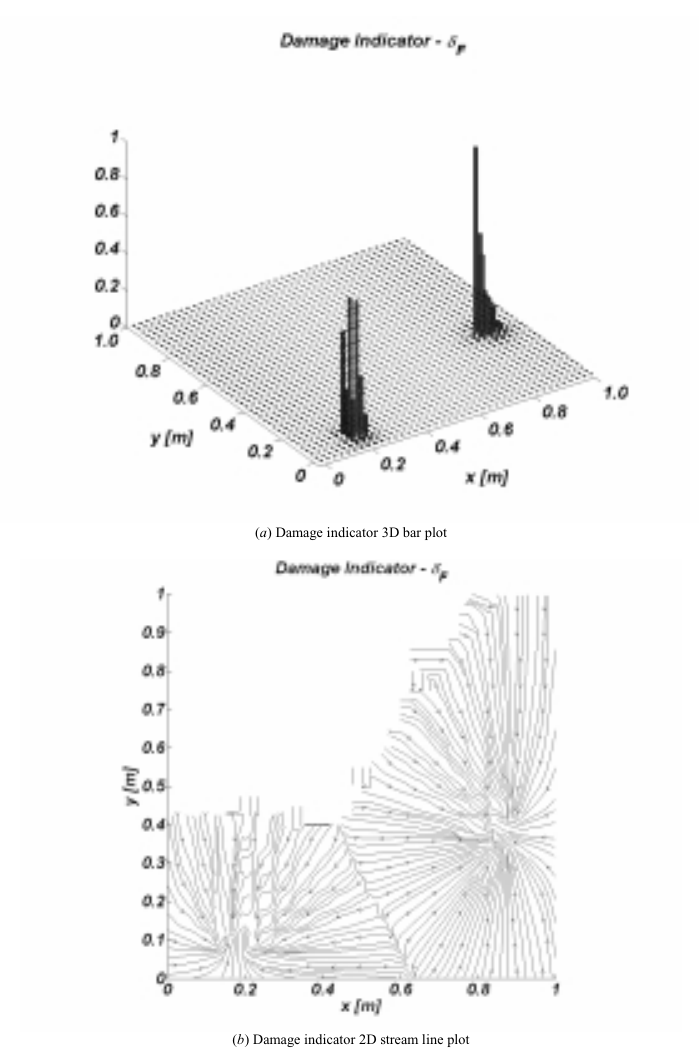
Fig. 13. Damage indicator: (a) 3D bar plot and (b) 2D stream line